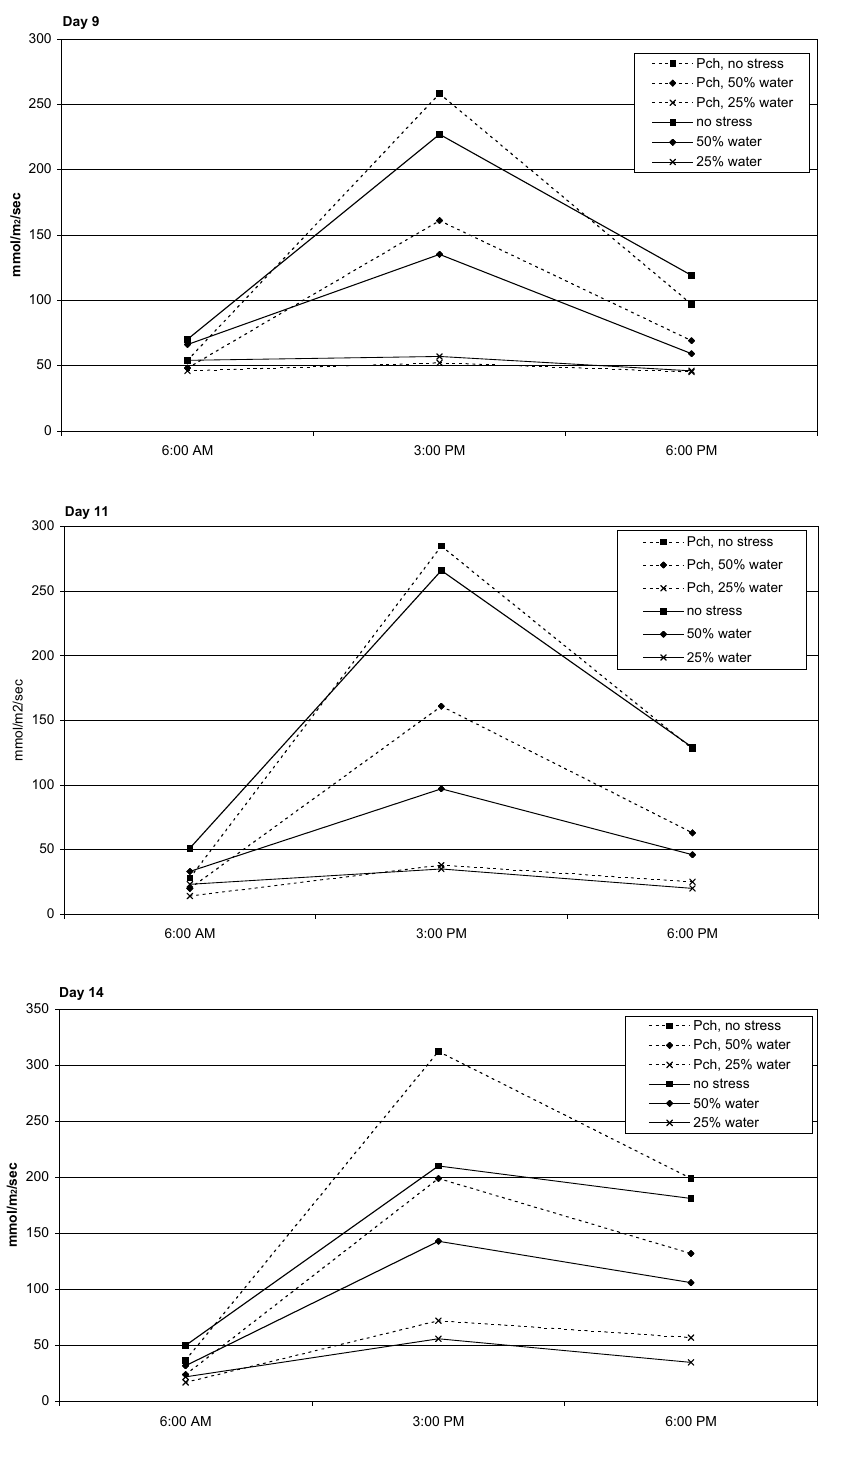
Fig. 7. Effect of 9, 11 and 14 days water stress on stomatal conductance of infected and uninfected Chardonnay, March